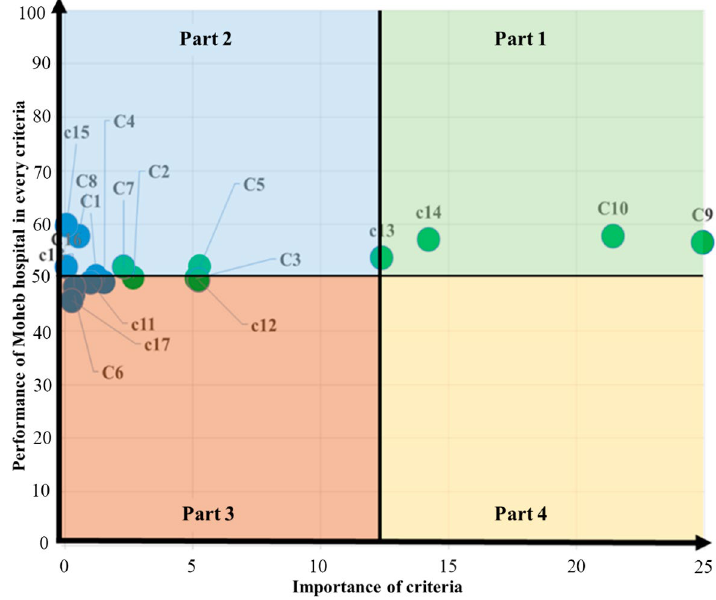
Figure 5. Hospital performance framework for new service